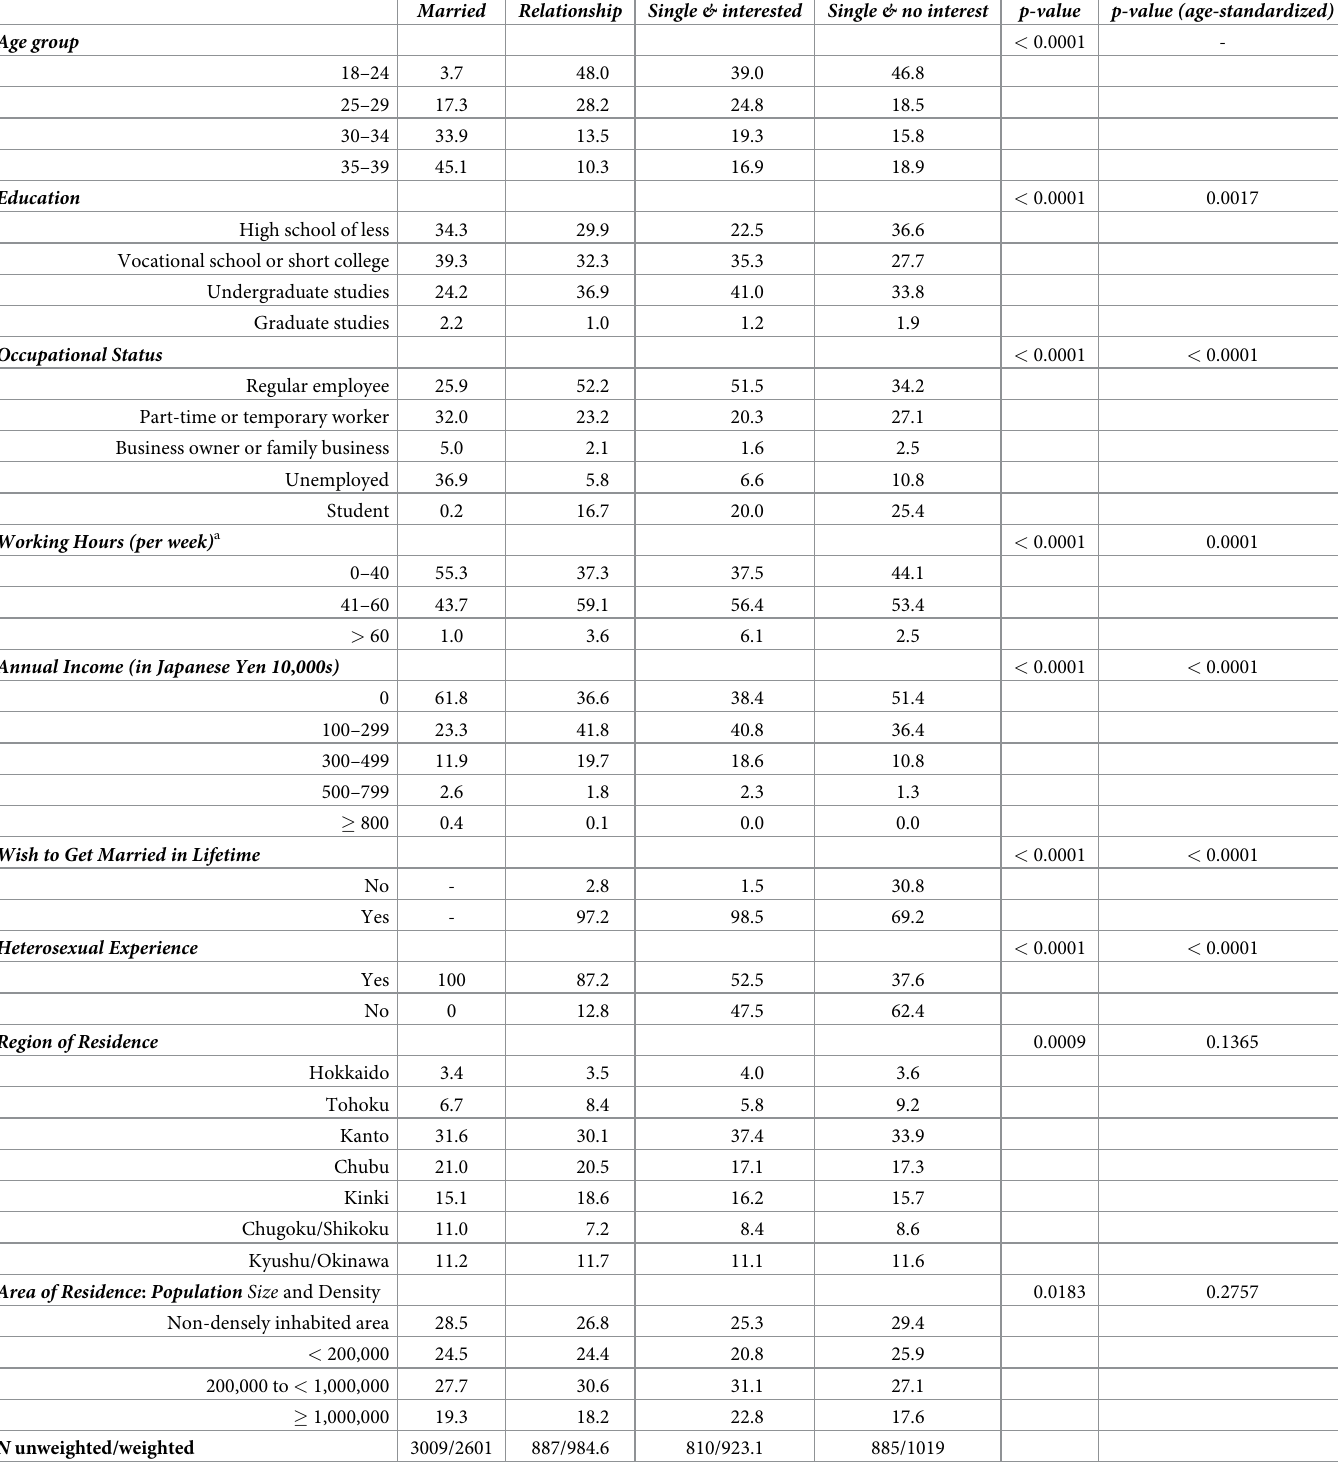
Table 1. Weighted population characteristics of women by relationship status and interest in relationship in 2015. Numbers are shown in percent. Married Relationship Single &